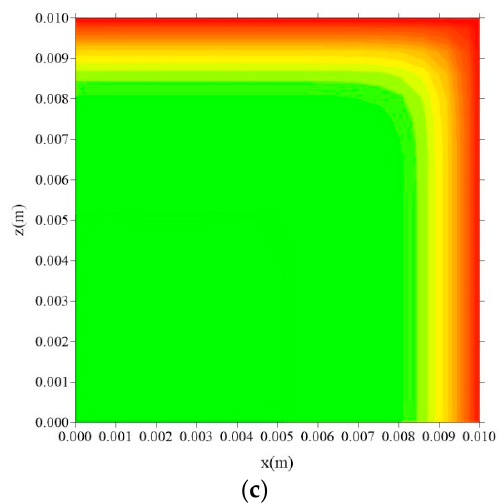
Figure 26. Distribution of free solute concentration (C in kg/kg) in plan y = R y /2 for different distances l y (t = 211 h, Cases 9, 11, and 12). In which: ( a ) l y = 0.001 m; l x = 0.1 m and l z = 0.1 m; ( b ) l y = 0.01 m; l x = 0.1 m and l z = 0.1 m; ( c ) l y = 0.1 m; l x = 0.1 m and l z = 0.1 m.